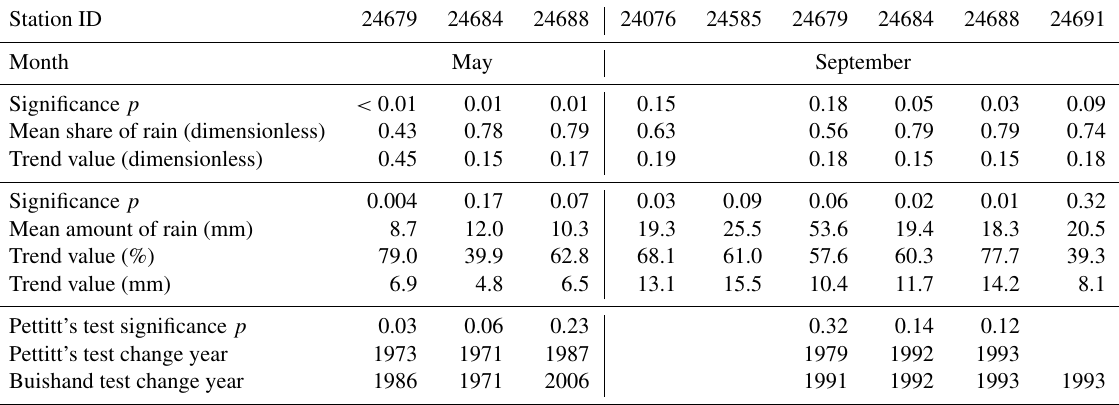
Table 5. Characteristics of rain and snow share in precipitation regime in May and September, 1966–2012 (the table contains only data for stations with changes).